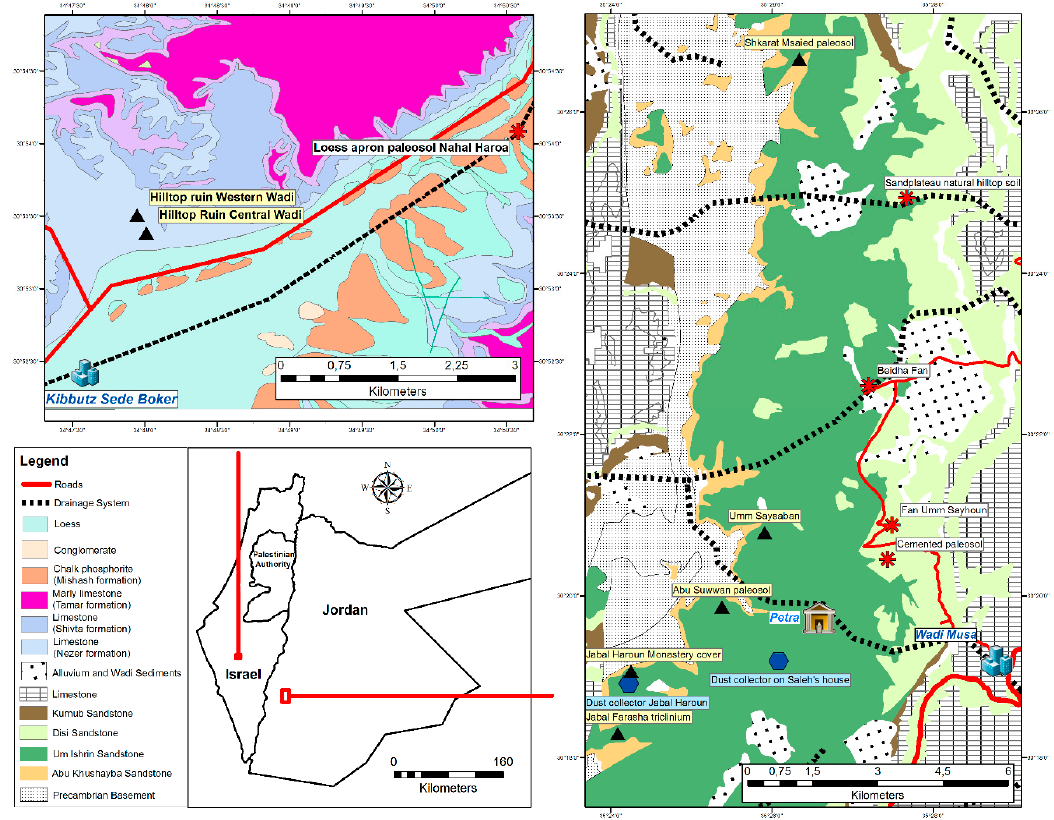
Figure 1. Map showing the locations of the investigation areas in Israel and Jordan and the main geological units. Black triangles mark the studied archaeological hilltop soils, orange stars mark the sampled reference sites, and blue hexagons mark the dust collectors in the Petra region. The dust collector in the Negev is located c. 4 km to the south from the sampling sites in Midreshet Ben Gurion. Rock outcrops and reference samples not marked on the map were located close to the sampled hilltop ruins.